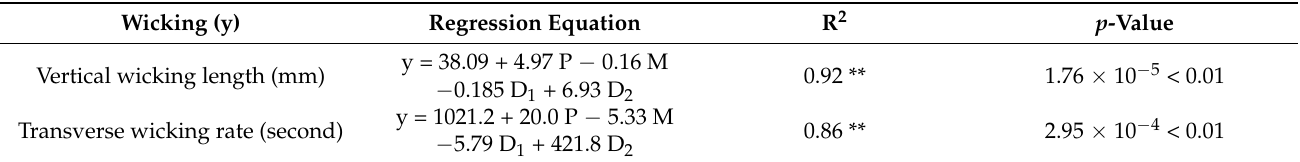
Table 5. Multiple linear regression analysis of wickability of the fabric specimens. Wicking (y) Regression Equation R 2 p -Value y = 38.09 + 4.97 P − 0.16 M Vertical wicking length (mm) Transverse wicking rate